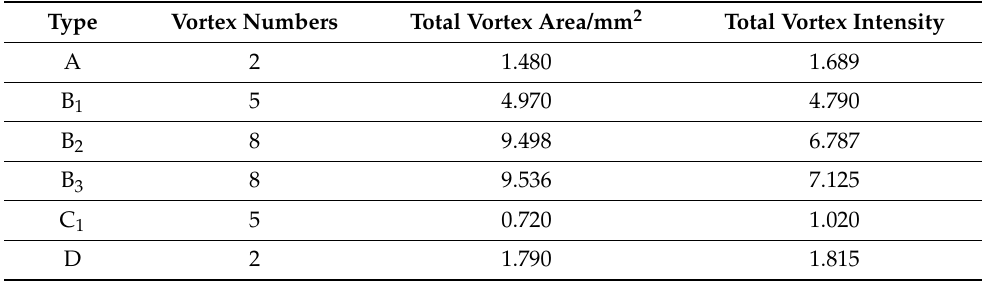
Figure 8. Streamlined diagram of the B emitters. ( a ) Streamlined diagram of the B 1 emitter; ( b ) Scheme 2 emitter; ( c ) stream- lined diagram of the B 3 emitter. Figure 9. Streamlined diagram of the C 1 emitter. Table 5 shows the sum of the vortex characteristics in a flow channel unit of the A, B, C 1 , and D emitters. The vortex intensity is defined as 𝜔 (cid:3400) 𝐴 , where A is the cross-sectional area of the vortex; ω is the rotational angular velocity, 𝜔 = (cid:3049) (cid:3045) ; r is the equivalent radius of the vortex area; v is the average tangential velocity at the boundary of the vortex area [25]. From Table 5, it can be observed that the number, the sum of area, and the intensity of the vortex in the B emitters are the largest in a flow channel unit. Compared with the A